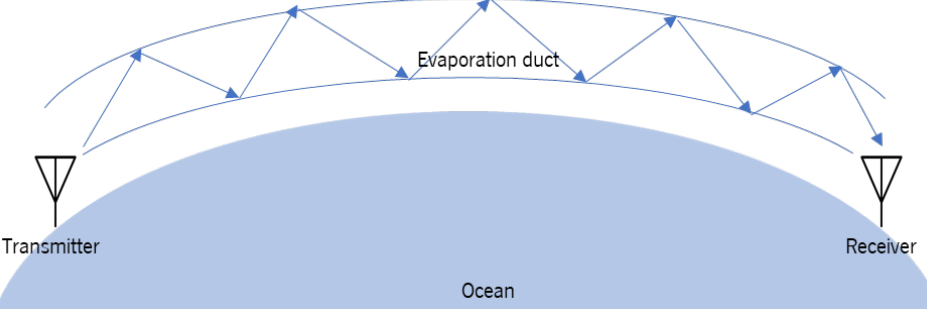
Figure 2. Representation of the evaporation duct and its use in long-distance communications.